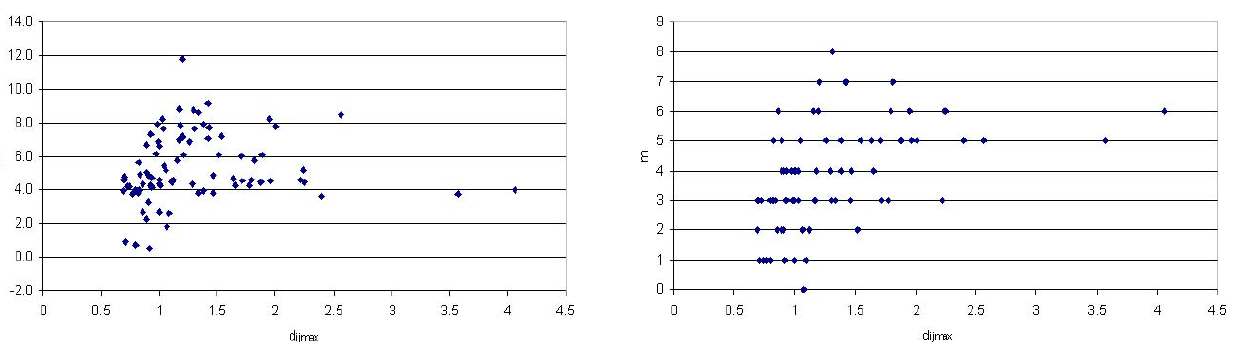
Fig. 8. m plotted versus d ij, max . Each point represents a pooling